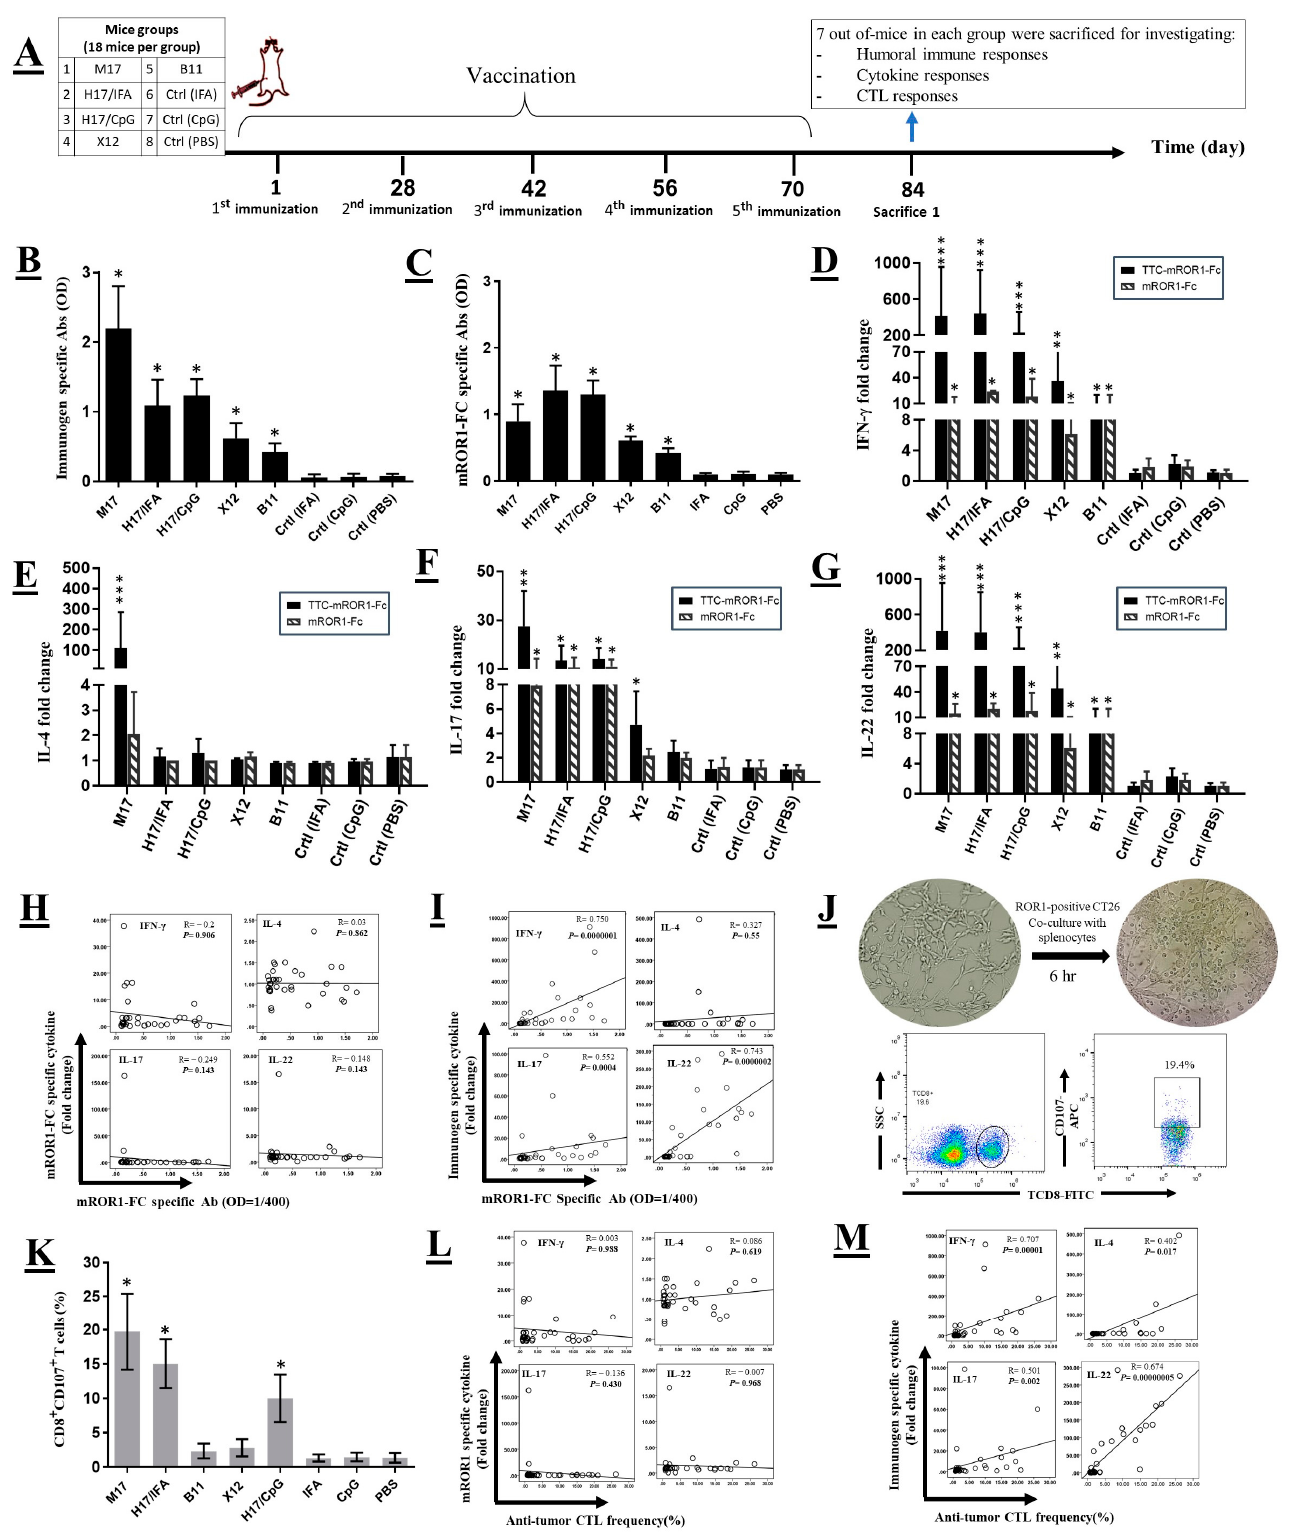
Figure 2. Assessment of immunogenicity of ROR1 fusion proteins. ( A ) Scheme of mice groups, immunization and assays timeline. Fusion proteins were administered subcutaneously at 5-time intervals. Two weeks after the fifth dose administration, seven mice of each group were sacrificed to investigate humoral and cellular immune responses. ( B ) Antibody against the immunizing protein and ( C ) mROR1 was assessed in serum 2 weeks after last immunization in all groups